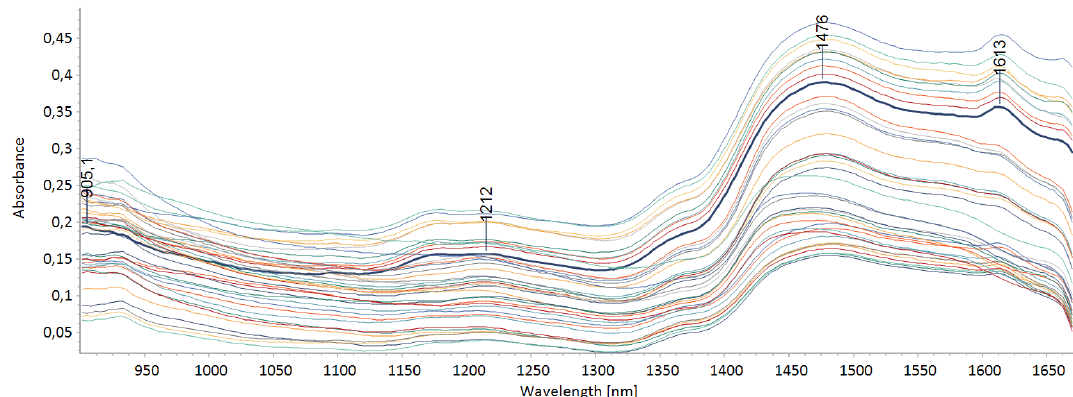
Figure 3. Absorption spectra of buckwheat straw samples in the near-infrared range (900–1680 nm) measured using the reflection technique.